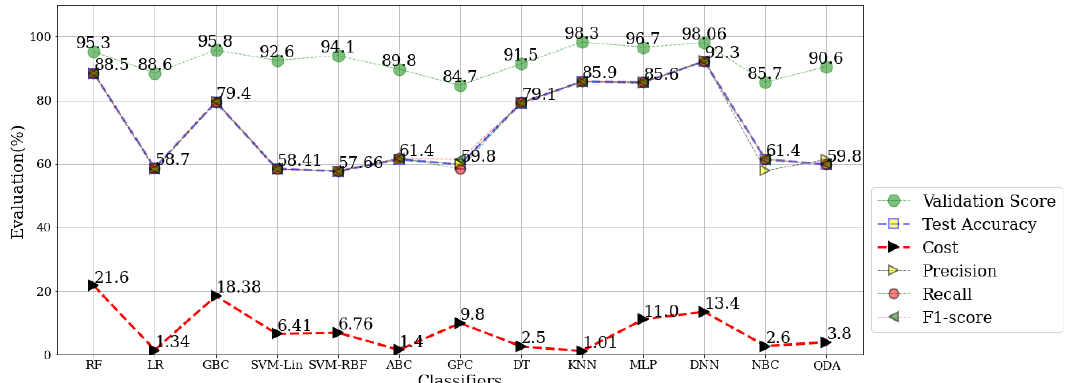
Figure 7. Diagnostics performance (test score) comparison of ML-based classifiers on the test